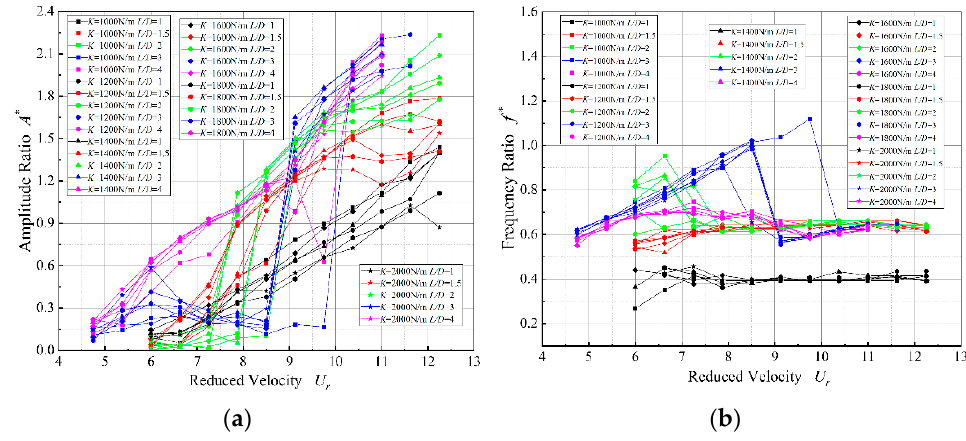
Figure 9. Amplitude and frequency responses for TRCTP. ( a ) Amplitude response; ( b ) Frequency responses.